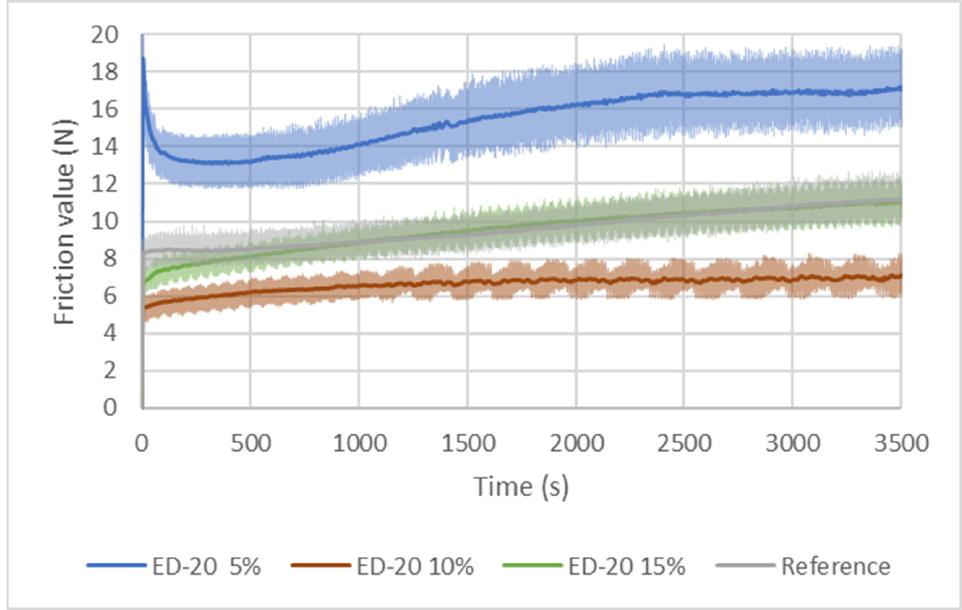
Figure 13. Friction characteristics of NBR modified with the addition of ED-20.